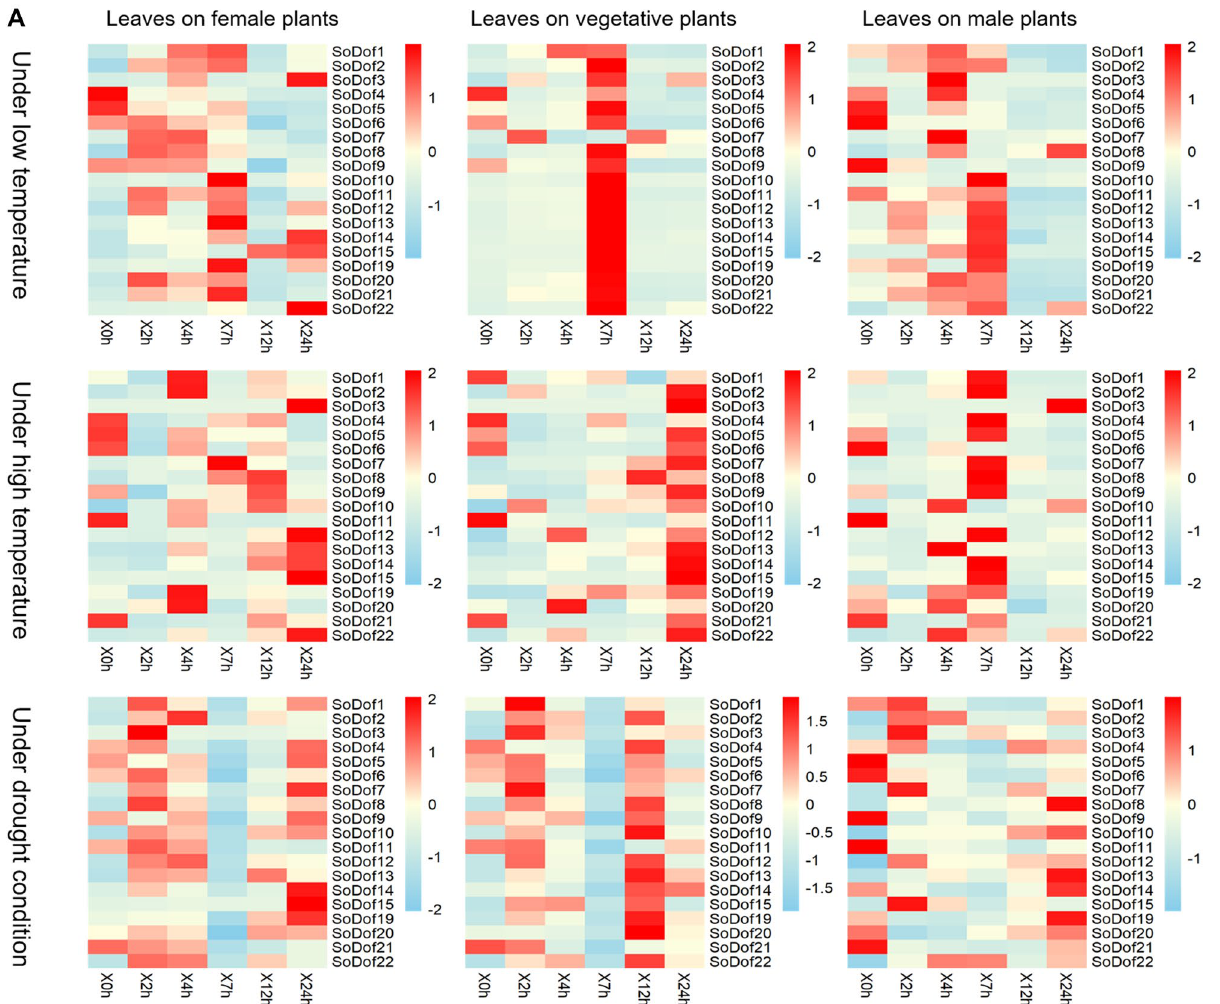
Figure 7. The expression pattern of SoDof genes under stresses. ( A ) The expression pattern of all SoDof genes under cold stress, heat stress and drought stress. The color scheme used to present expression level is sky-blue/ red: light-yellow boxes indicate low variation in gene expression, sky-blue indicate a fold decrease, and red boxes indicate a fold increase in relation to mean value. The Y-axis indicates each SoDof gene and the X-axis indicated the time after treatment. The expression value were calculated as the arithmetic mean. ( B ) The expression level of down-regulated SoDofs . F- SoDof means the SoDof gene in female plants; V- SoDof means the SoDof gene in vegetative plants; M- SoDof means the SoDof gene in male plants. The Y-axis indicates relative expression level and the X-axis indicated the time after treatment:0 h (gray); 2 h (light brown); 4 h (orange); 7 h (green); 12 h (purple);24 h (pink). Asterisk indicates a significant difference from 0 h (p < 0.05). Error bars indicate standard error of independent technological replicates. Figure ( A ) and ( B ) were made by Graphpad